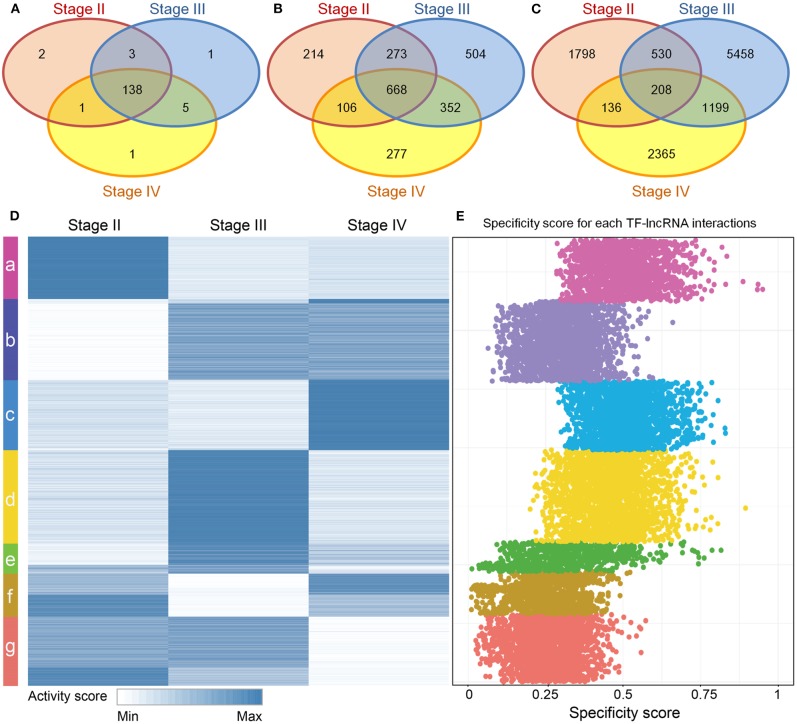
Dynamic TF-lncRNA interactions across the progression of OC. (A–C) Venn diagrams showing the overlaps of TFs, lncRNAs and their regulation in different stages. TFs in different stages of OC regulate different target lncRNAs. (D) The activity profile for TF-lncRNA relationships across different stages of OC. The co-expression coefficients for TF-lncRNA pairs in each stage of OC were used as activity scores. Clustering analysis revealed that different groups of TF-lncRNA relationships were apparently activated in one or more stages of OC. (E) The corresponding specificity scores were plotted. The groups a, c, d, and e have higher specificity scores than other groups, indicating these groups are stage specific.